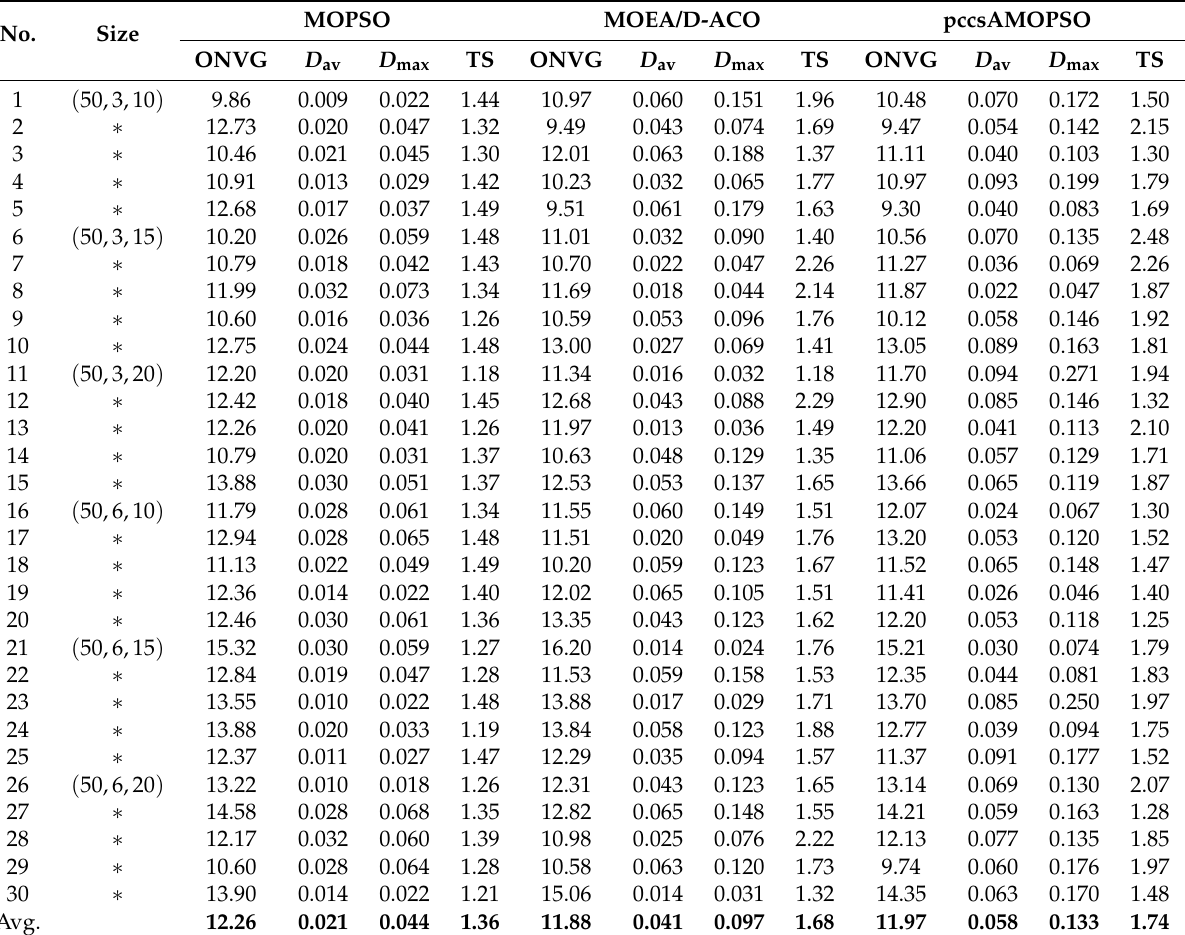
Table 4. Comparison of MOPSO with MOEA/D-ACO and pccsAMOPSO on the test instances with 50